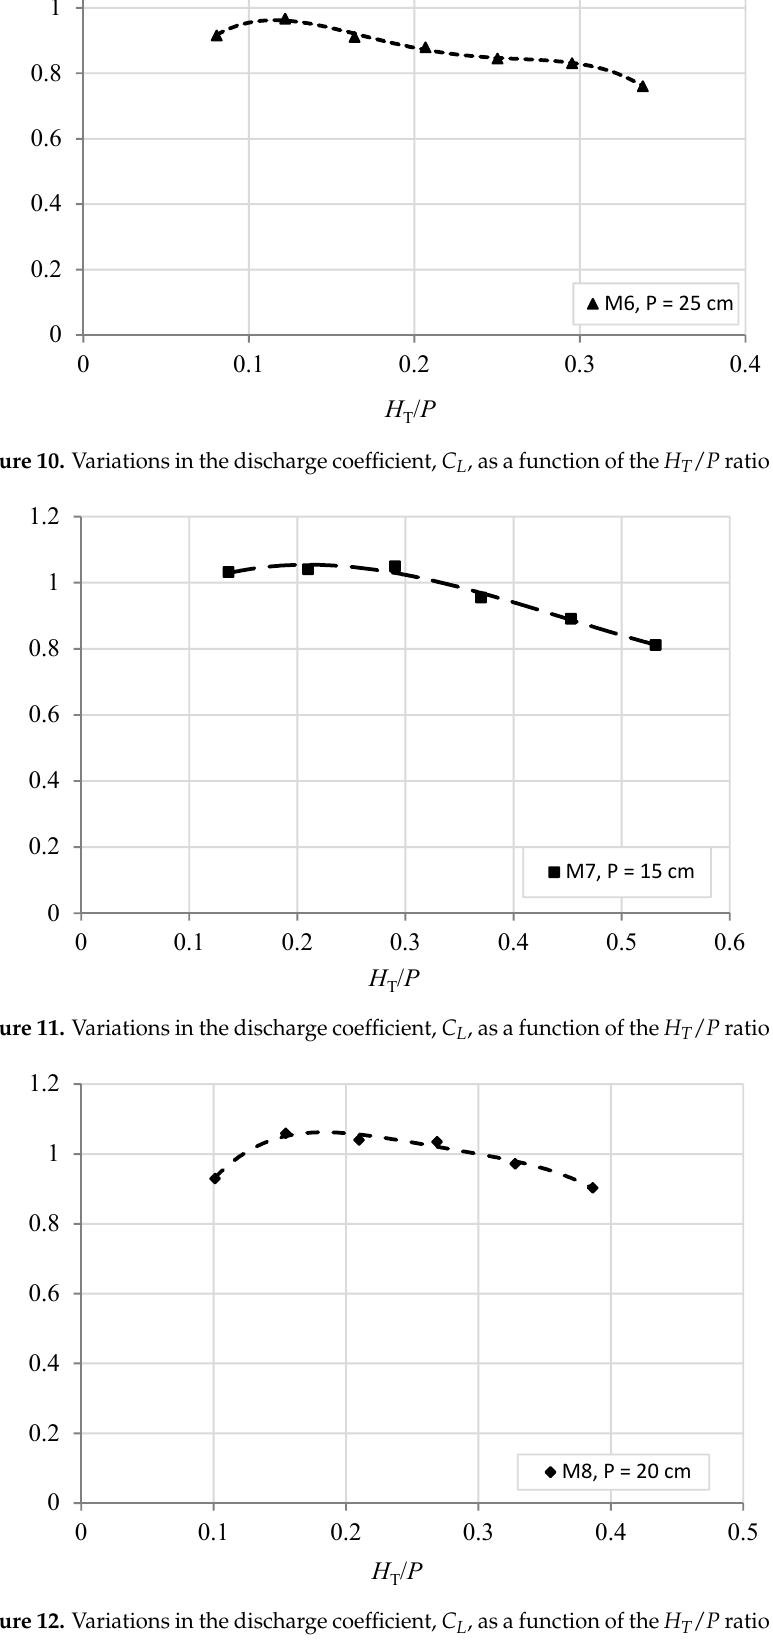
Figure 12. Variations in the discharge coefficient, C L , as a function of the H T /P ratio for the M8 model.